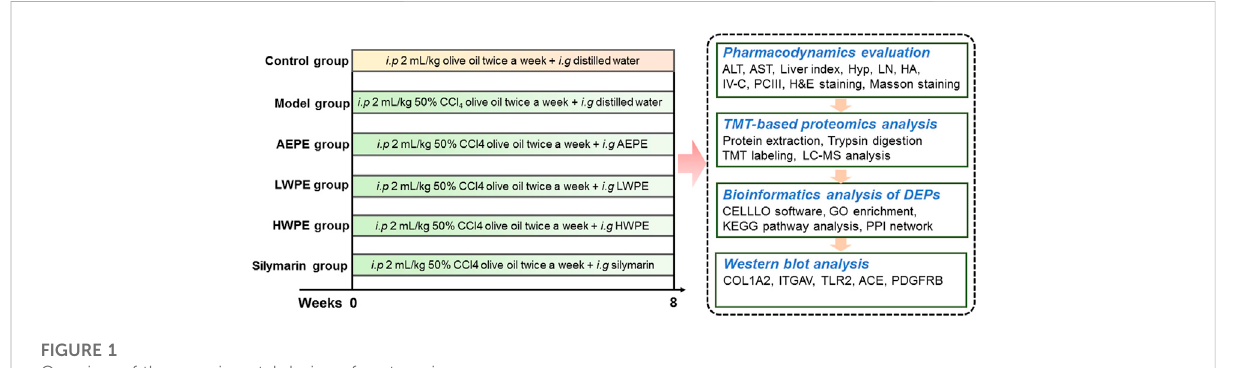
FIGURE 1 Overview of the experimental design of